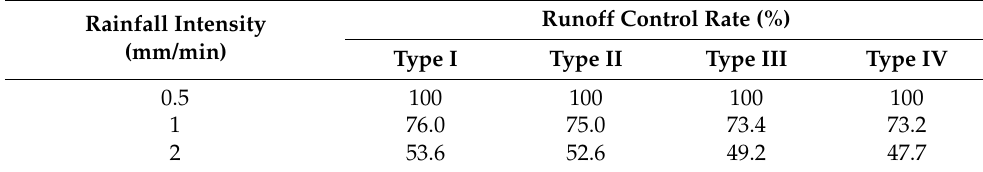
Figure 5. Yield and infiltration of each permeable pavement under different rainfall intensities. Table 3. Runoff control rate of each permeable pavement under different rainfall intensities.